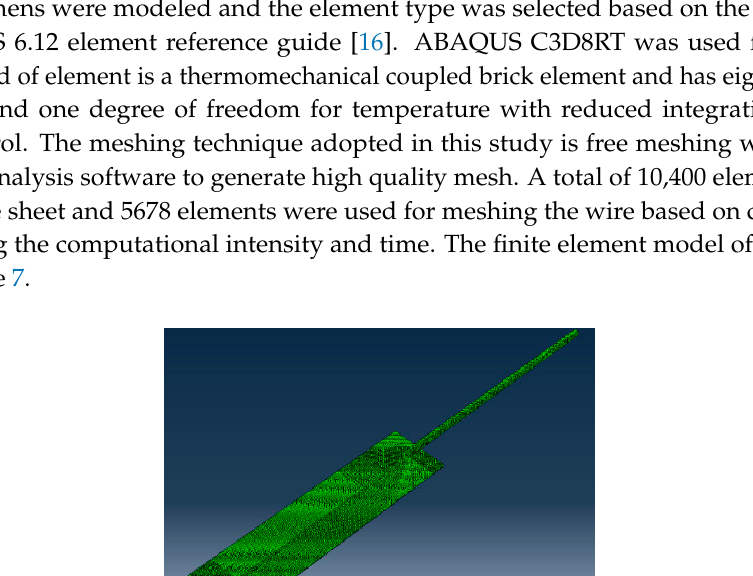
Figure 8. Area of deformation. 3.6. Calculation of Heat Flux The heat generation due to deformation at the interface is the power dissipated over the weld area. Power at the weld area depends on weld force which is a function of temperature dependent yield strength and the clamping force, as shown in Equation (1).